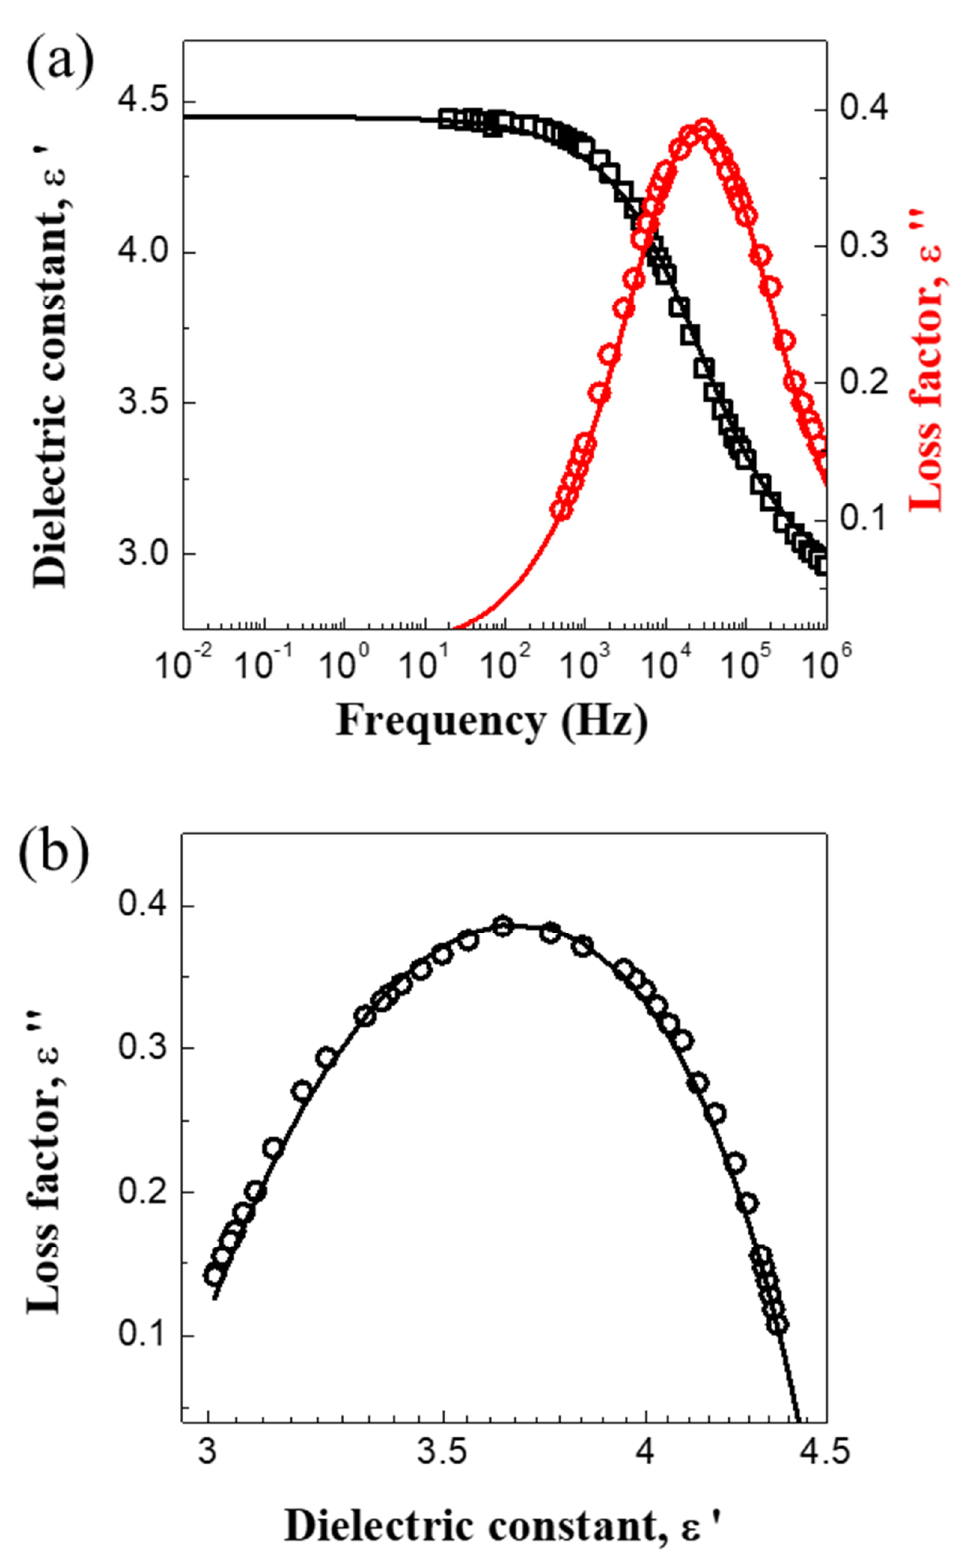
Figure 6. ( a ) Dielectric spectra (dielectric constant, ε’: black square; dielectric loss, ε’’: red circle) and ( b ) Cole–Cole mode data of GO/PDPA microsheet composites-based ER fluid (10 vol.%). For ER behaviors of the ER suspension, both steady shear and dynamic oscillation measurements were successively carried out using a rotational rheometer. Figure 7 shows typical